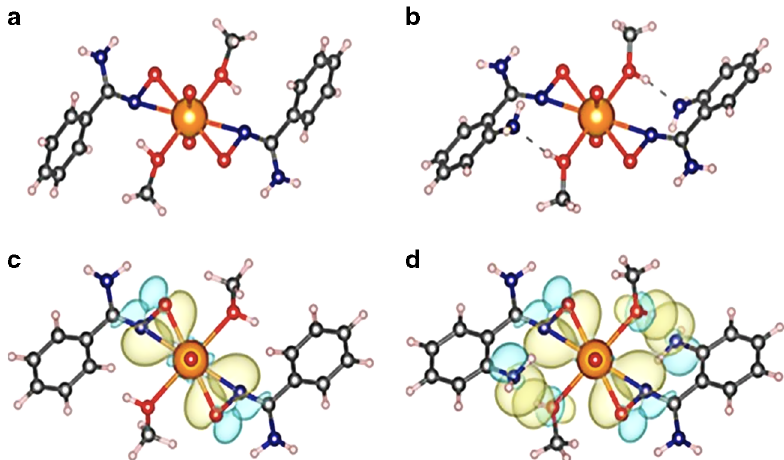
Fig. 4 Crystal structures of uranyl complexes. a , b Single crystal structures of UO 2 (AO) 2 (MeOH) 2 and UO 2 ( o NH 2 -AO) 2 (MeOH) 2 , respectively. c DFT optimized structure of UO 2 (AO) 2 (MeOH) 2 with dative U – O and U – N σ -bonds in UO 2 (AO) 2 (MeOH) 2 . d DFT optimized structure of UO 2 ( o NH 2 - AO) 2 (MeOH) 2 with dative U – O and U – N σ -bonds along with second sphere hydrogen bonding interactions, characterized by overlap of the p -type